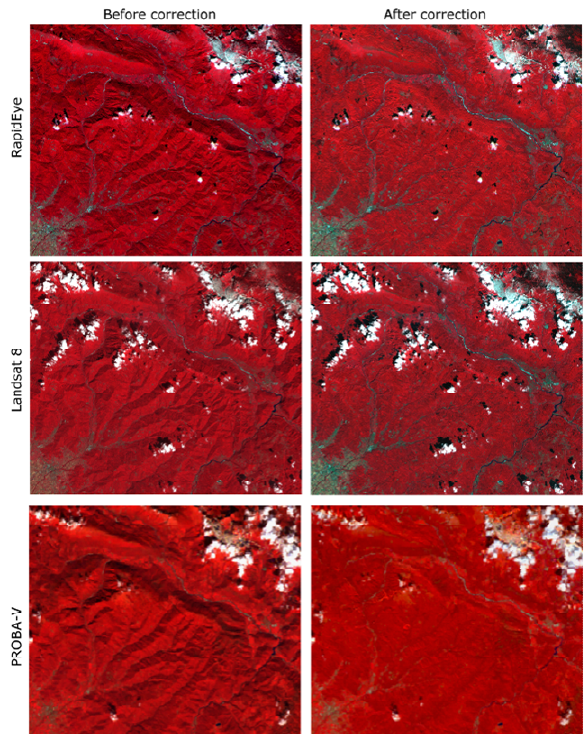
Figure 6. Final result of topographic correction in hilly area for all three sensors. Colour image is composed of NIR-R-B/G spectral bands.